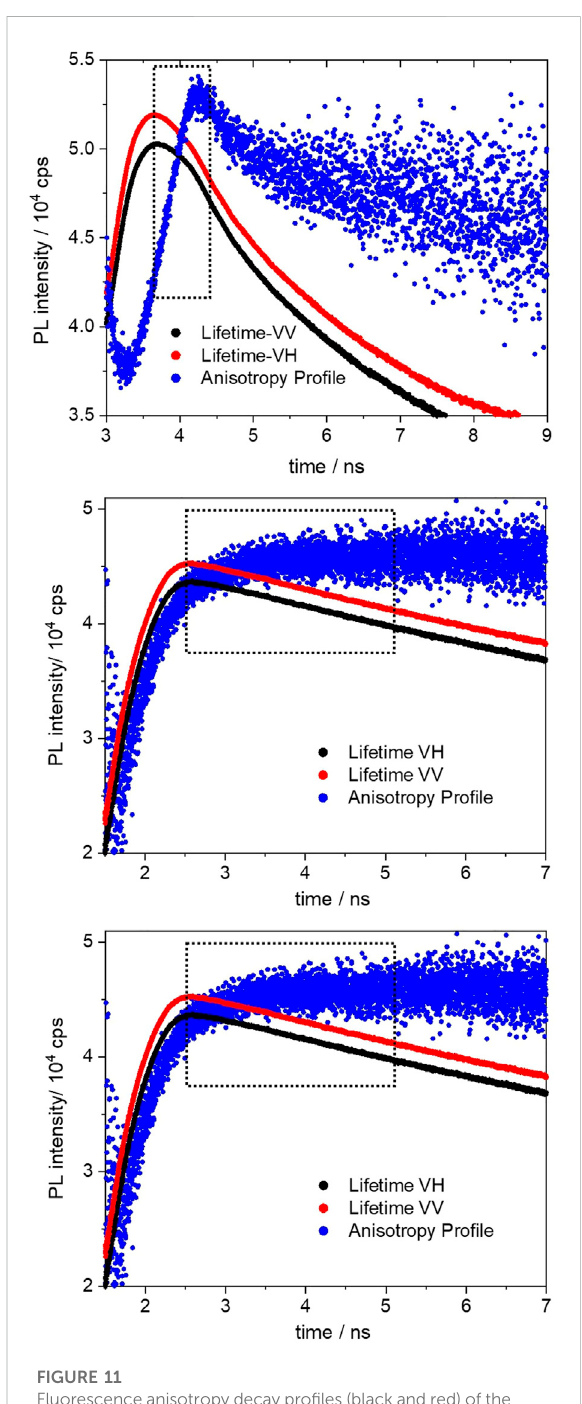
FIGURE 11 Fluorescence anisotropy decay pro fi les (black and red) of the 1% (top), 2% (middle) and 5% (bottom) BOPHY2-PMO, recorded at 560 nm. The blue pro fi les are the anisotropy curves generated from the respective